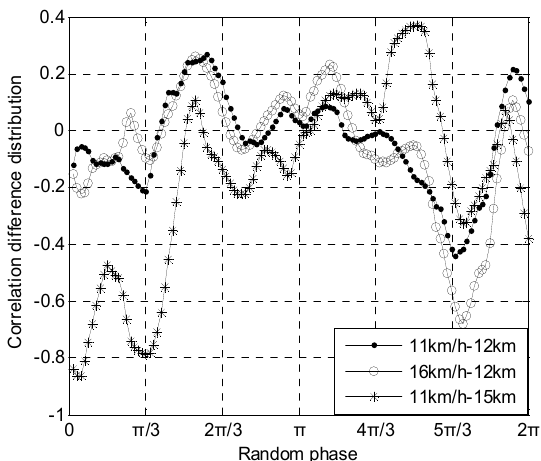
Figure 7. Correlation difference distribution of Monte Carlo method.